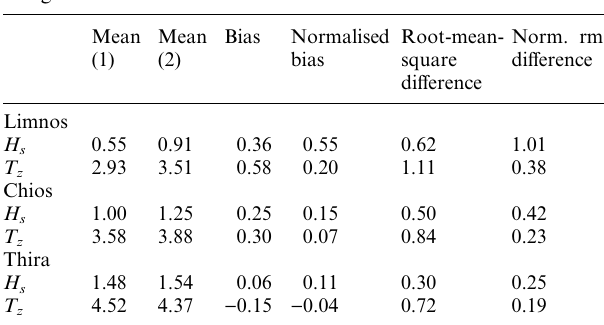
Table 12. Statistics for the storm February ) March 1990, -80 points. Comparison of results from WAM and AUT wave model